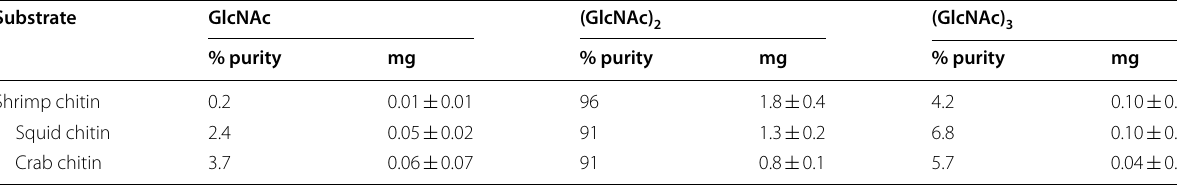
The % purity for each hydrolytic product was calculated from the individual peak area divided by the total peak area obtained from all the products in the HPLC chromatogram. Values are means SD from two independent ±